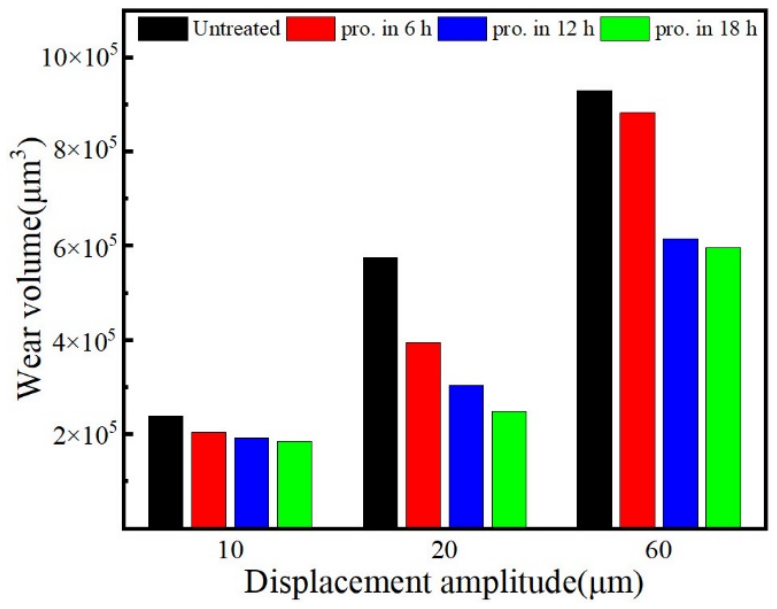
Figure 11. Wear volume of wear scars on balls after various process times and at different displacement amplitudes.